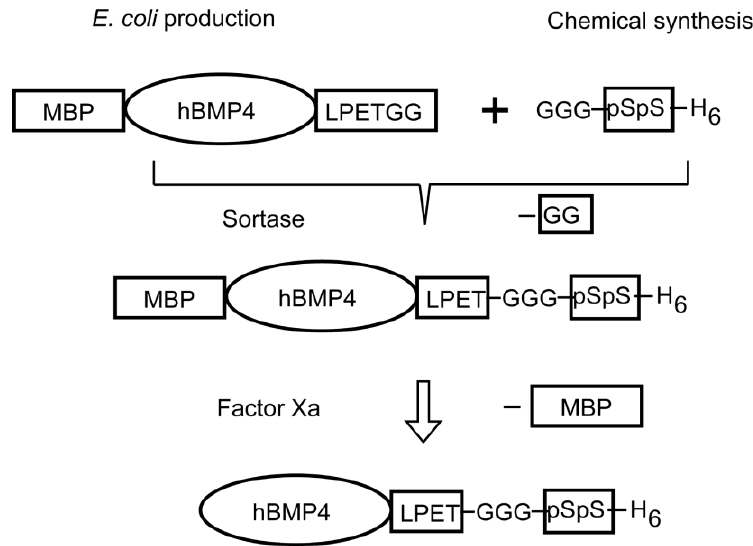
Figure 6. Scheme of the production and purification of hydroxyapatite-binding bone morphogenetic protein (BMP). Using a sortase reaction, a peptide carrying noncanonical amino acids (pSpS) was fused with the protein MBP-hBMP4 bearing a recognition sequence. After cleavage of the maltose-binding protein (MBP) moiety with Factor Xa, hBMP4-pSpS was isolated by His tag